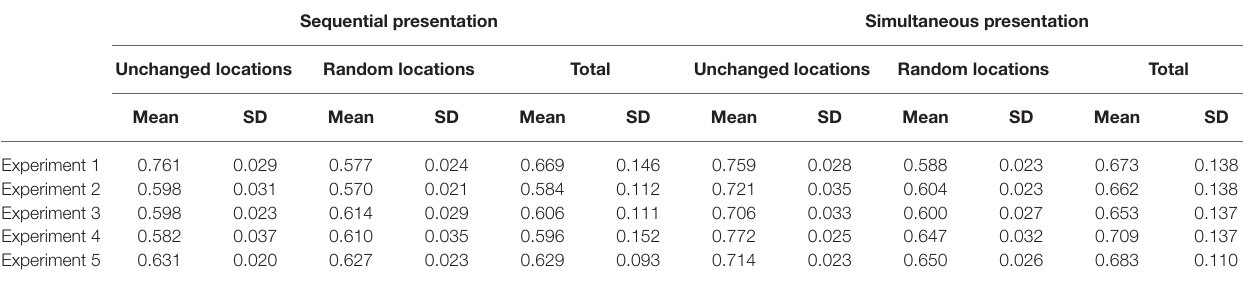
TABLE 2 | Hits in all experimental conditions in the five experiments.